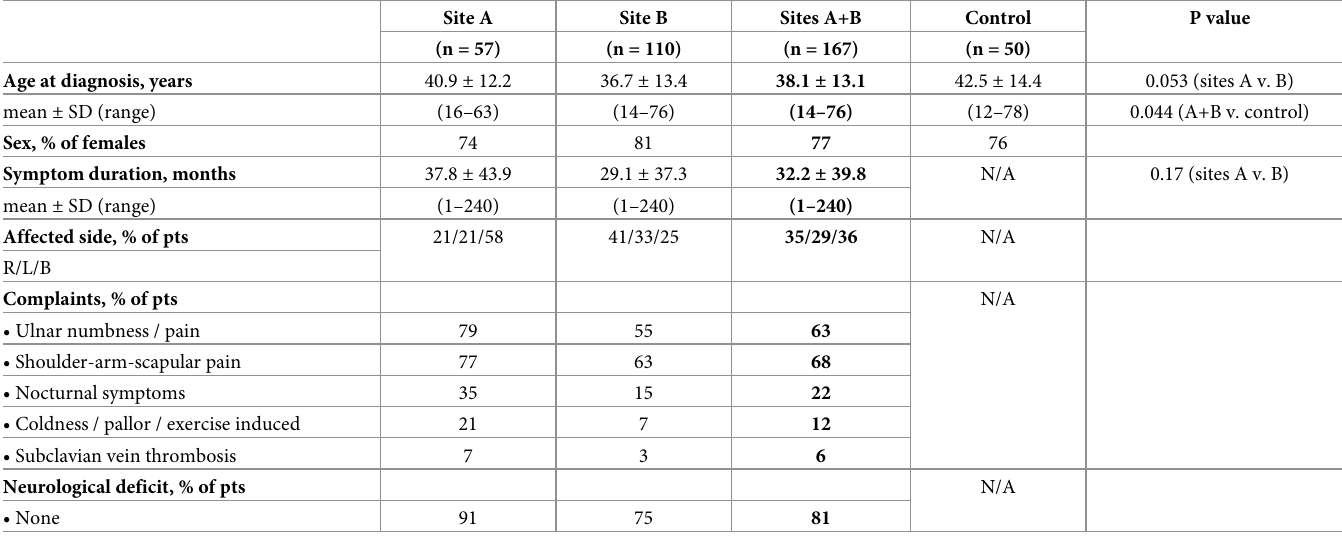
Table 1. Summary of demographic and clinical